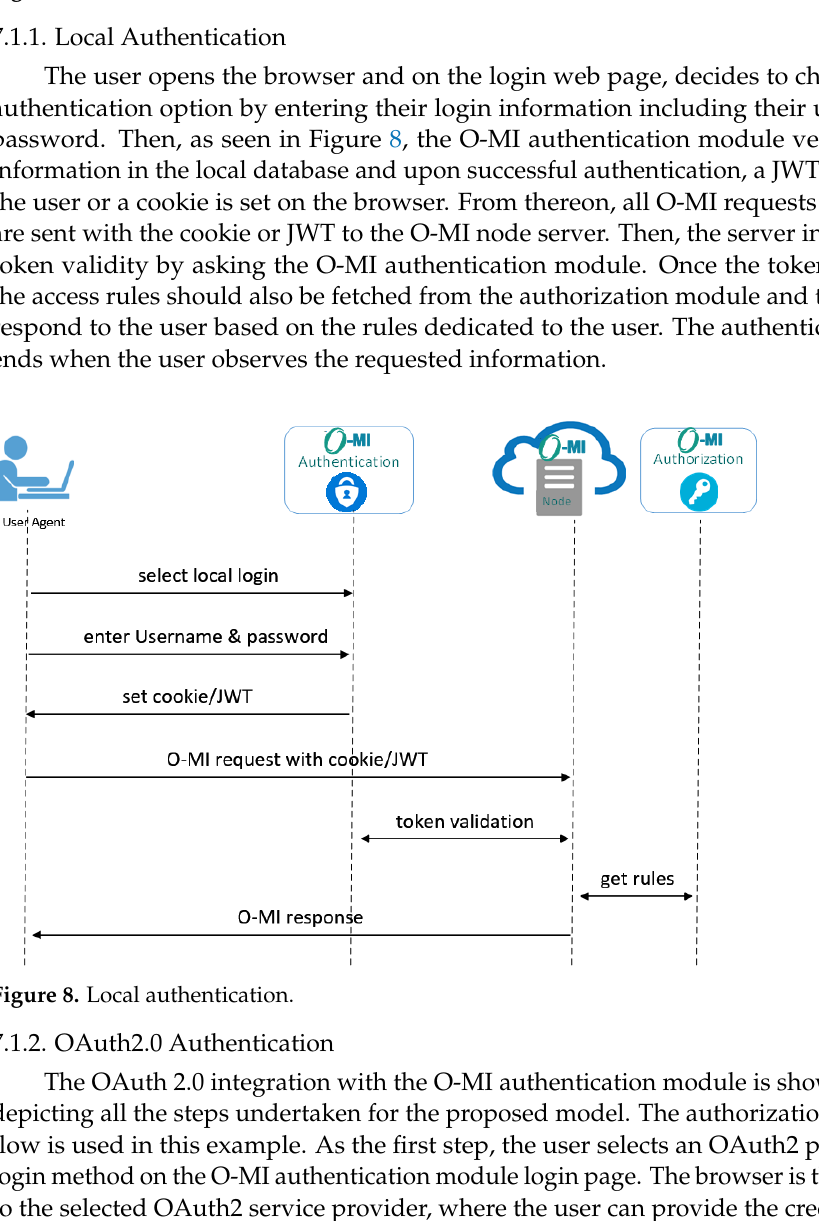
Figure 7. Authentication and authorization module.